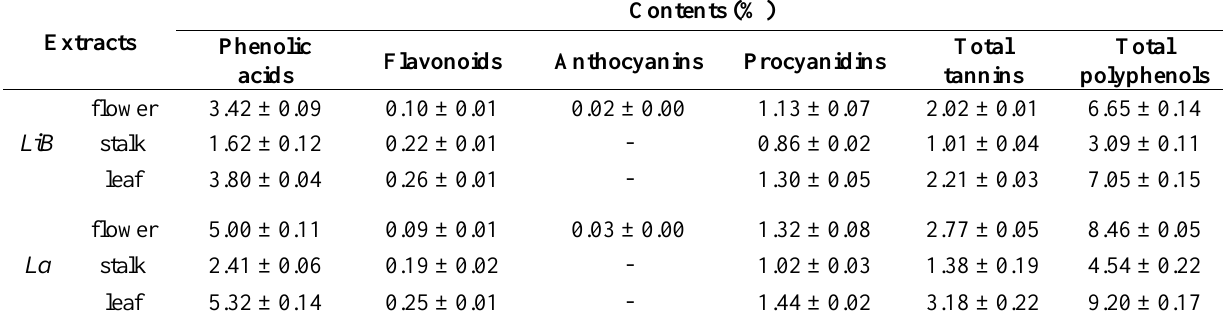
Table 1. Contents of phenolic acids, flavonoids, anthocyanins, procyanidins, total tannins and total polyphenols in the various Lavandula x intermedia 'Budrovka' (LiB) and L. angustifolia (La)